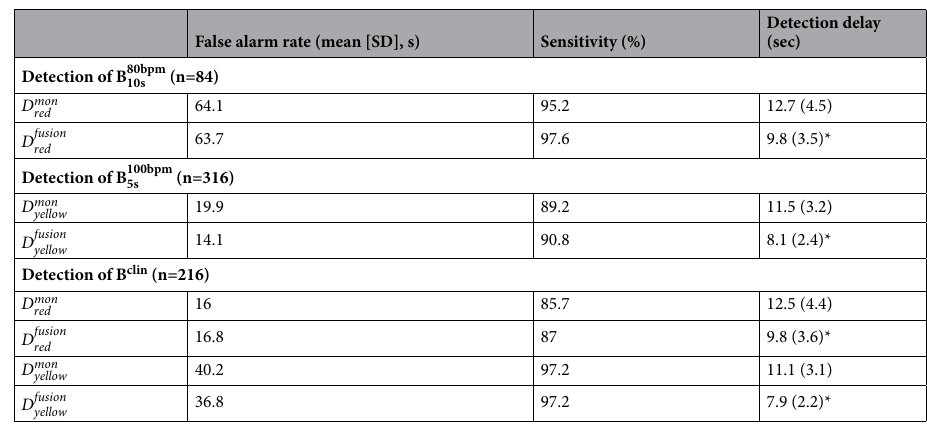
Table 2. Comparison of bradycardia detection performances. False alarm rate, sensitivity and detection delay are reported according to the gold-standard annotations. Red alarm and Yellow alarm are respectively denoted D mon D mon red , yellow for the monitors currently used in neonatal units. The proposed fusion method is denoted D fusion yellow for Red and Yellow alarms respectively. *Significant difference delays using the Wilcoxon signed-rank